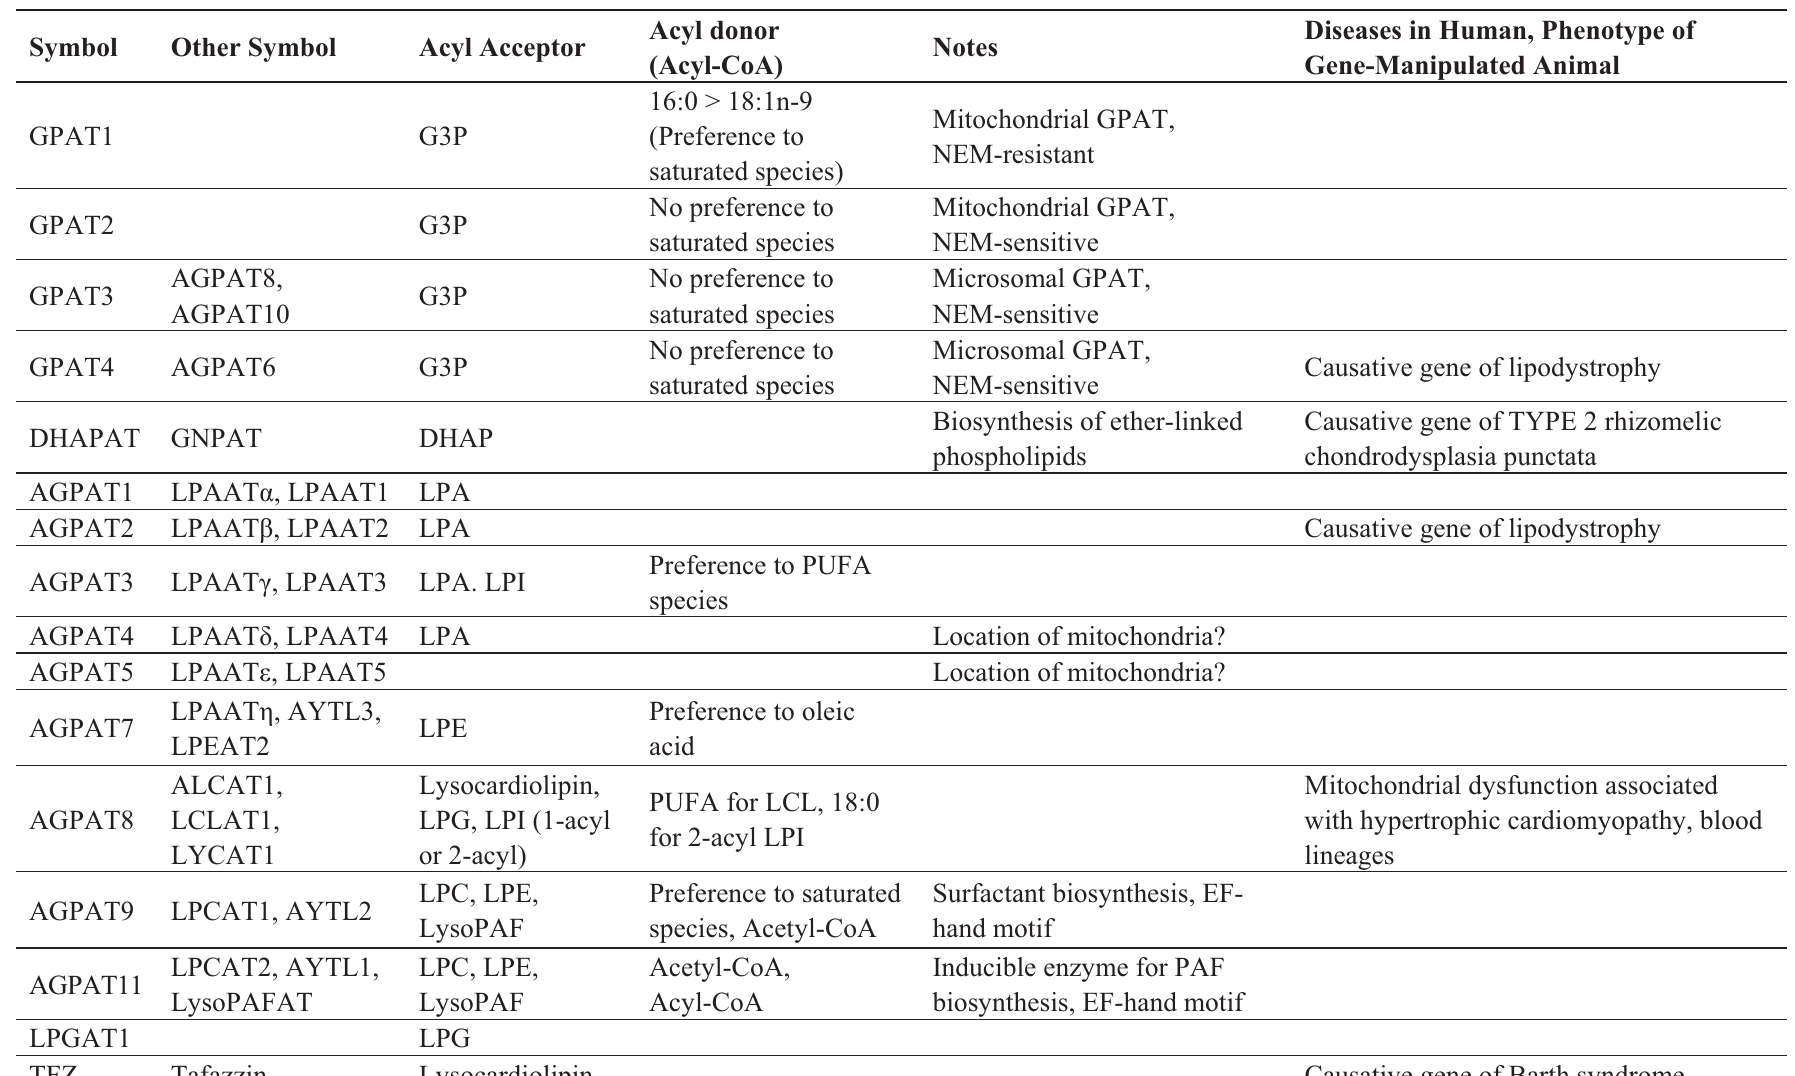
Table 1. Summary of GPAT/AGPAT family